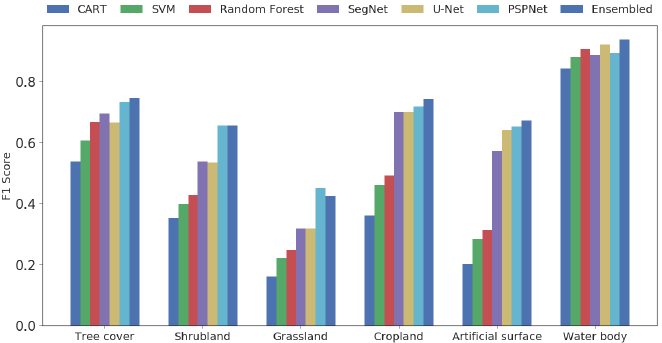
Figure 7. F1 score for each method across categories.